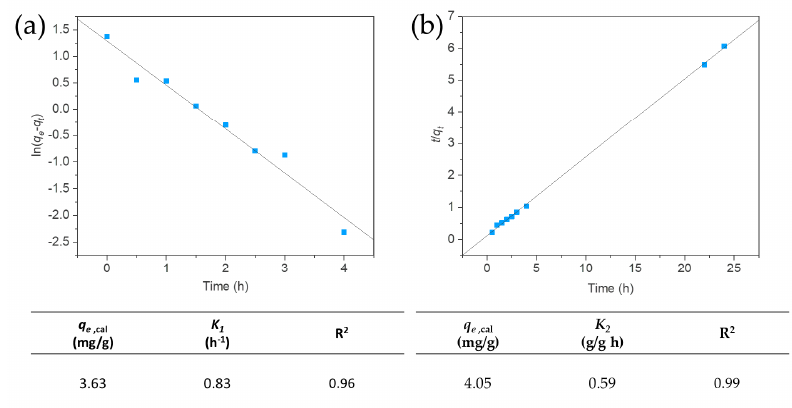
Figure 7. Application of ( a ) pseudo-first-order adsorption model and ( b ) pseudo-second-order adsorption model. The calculated values from Equations (8) and (9) are reported in the tables under graphs ( a ) and ( b ) respectively.